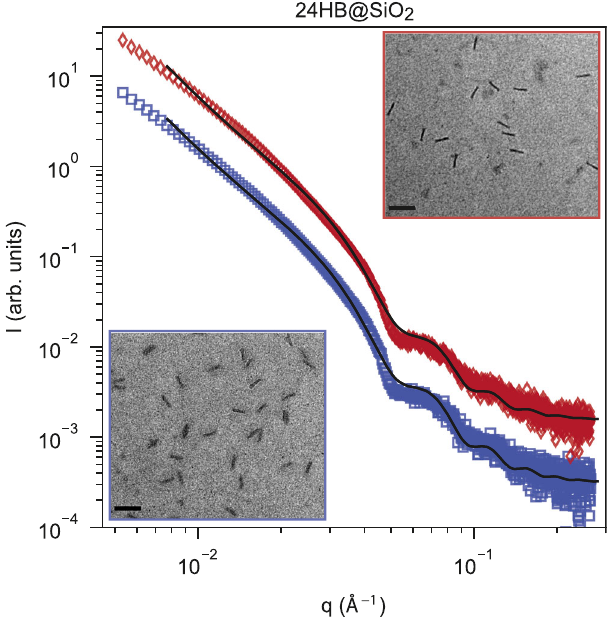
Fig. 3 | Temperature stability of condensed silici fi ed 24HBs veri fi ed by SAXS and TEM. SAXS intensities of 24HBs@SiO 2 ( R SiO 2 =74 : 5±0 : 4Å) measured atroom temperature (blue squares) and after heating the structures to 60°C for 30min (red diamonds) and TEM micrographs of 24HB @SiO 2 at room temperature (blue frame) and after heating to 60°C for 30min (red frame) are shown in the insets. Scale bars: